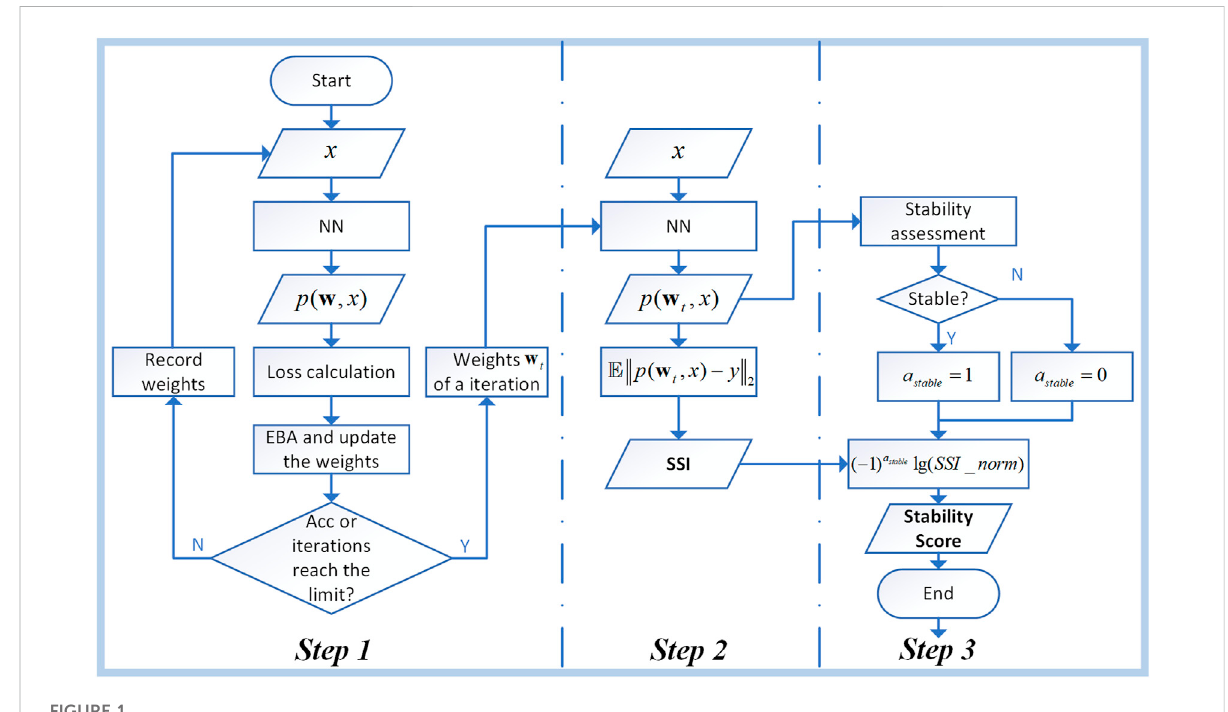
FIGURE 1 The procedure to evaluate the signi fi cance and